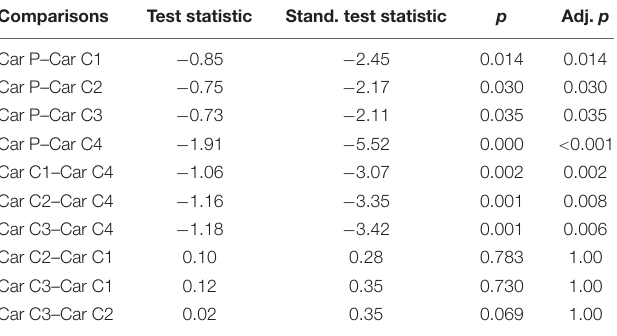
TABLE 1 | Manipulation check: Paired comparisons for Friedman’s ANOVA.